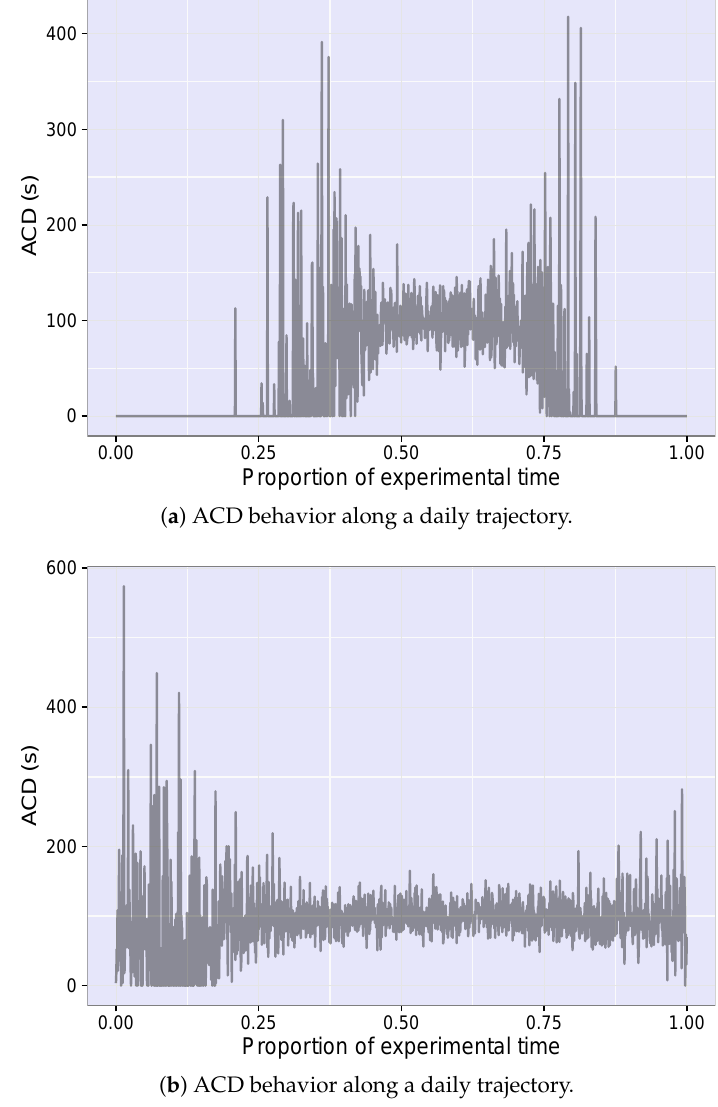
Figure 7. Analysis of the Average Call Duration (ACD). ( a , b ) represent the ACD for the first and second profiles,